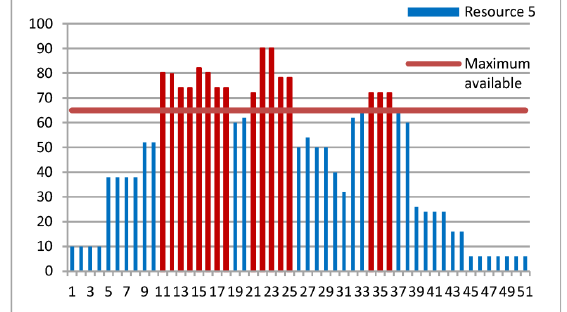
Figure 55. Daily usage of resource 5 throughout the calendar of the project (before using the method)-Experiment